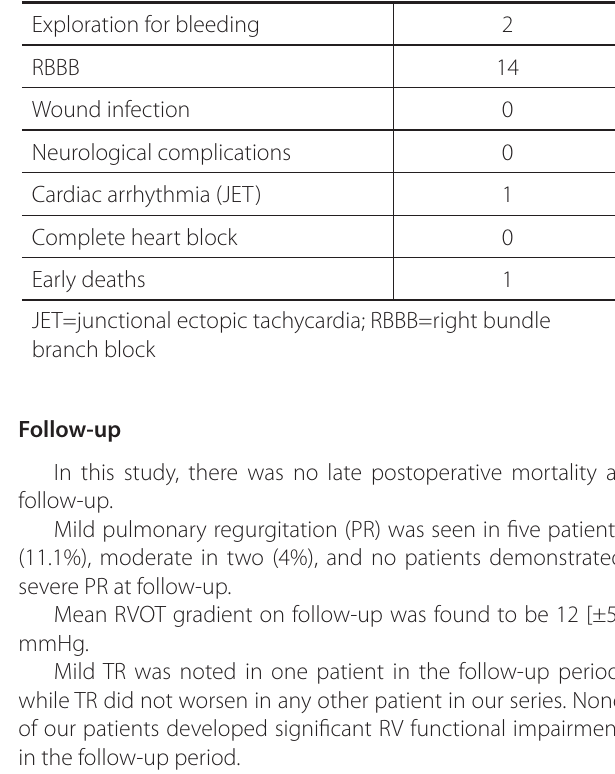
Table 3 . Postoperative complications.